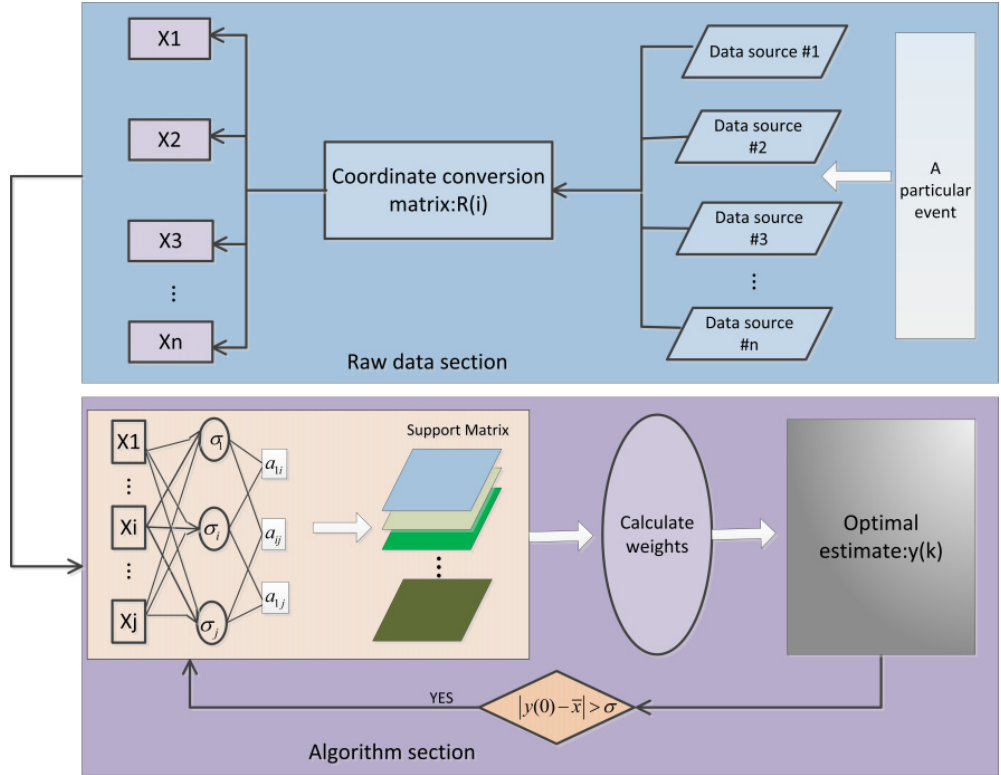
Figure 3. Flow chart of the algorithm for fusing calibration parameters. Table 1. Comparison of fusion-calibration algorithms with conventional algorithms.